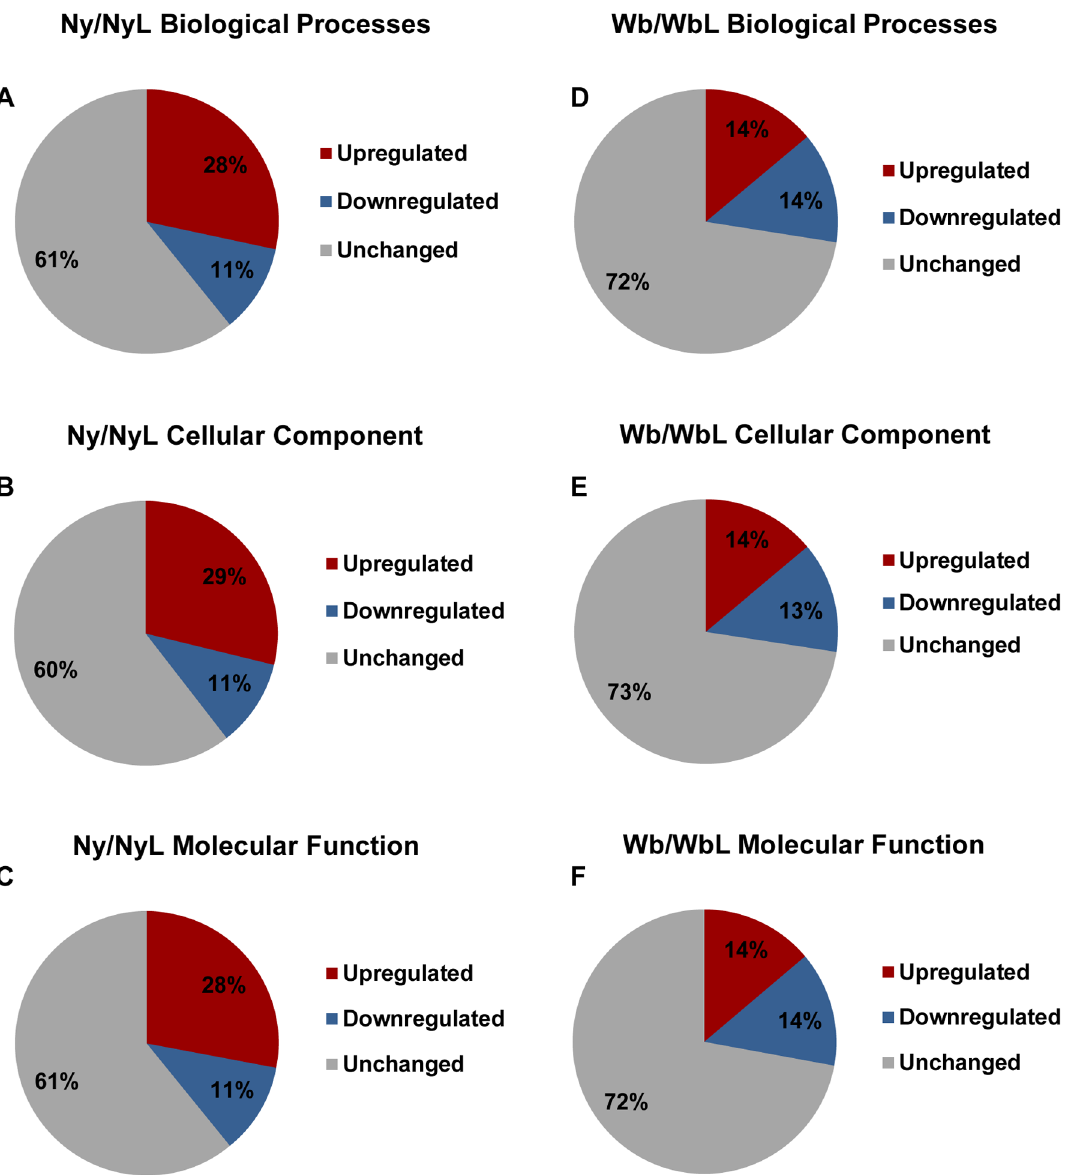
Fig 5. The distribution of up- or down-regulated genes among the major Gene Ontology (GO) categories. (A-C), showing the proportion of color-coded Asian citrus psyllid contigs for each group, as follows: up-regulated (red), down-regulated (blue), and unchanged (grey), in response to Ca . Liberibacter asiaticus (CLas) infection of nymphs (Ny), based on the Biological Process, Cellular Components and Molecular Functions GO categories. Distribution of contigs with altered expression in the GO categories, Biological Process, Cellular Components and Molecular Functions (D-F) of up-regulated (red), down- regulated (blue), and unchanged (grey) candidates, in response to CLas infection of ACP adults (Wb). Contigs classified into GO categories were identified as differentially expressed using p -value cut off 0.05 (edgeR